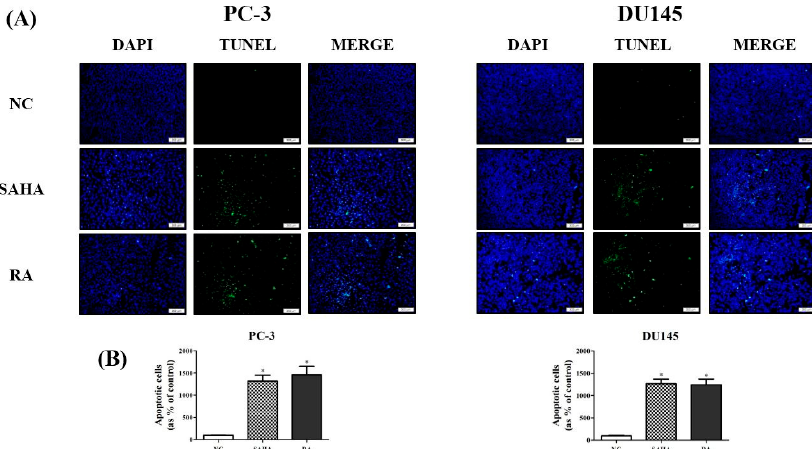
Figure 4. Effects of SAHA and RA on DNA fragmentation in PC-3 and DU145 cell lines. After both cell lines were seeded at 3 × 10 5 cells per well in 24-well plates and treated with media containing NC (DMSO), SAHA (1 µ M) and RA (200 µ M), terminal deoxynucleotidyl transferase dUTP nick end labeling (TUNEL) assay was performed. ( A ) The data indicated that nuclei were stained with 4 (cid:48) ,6-diamidino-2-phenylindole (DAPI), and DNA fragmentation was stained with TUNEL. DAPI and TUNEL were merged to observe apoptotic nuclei. ( B ) The apoptotic cells presenting DNA fragmentation were quantified separately. The results are expressed as means ± SD. * p < 0.05: a significant difference versus control. MERGE means the combined picture of DAPI and TUNEL